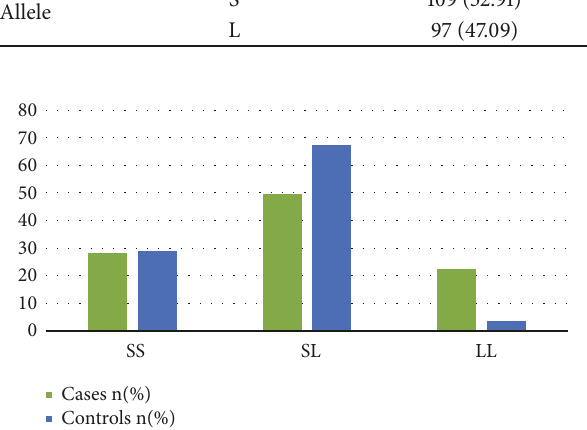
Figure 4: Prevalence of the different genotypes (SS, SL, and LL) of the Ser217Leu variant of the ELAC2 gene in isolates from the Littoral Region. SS= wild type, SL = heterozygous mutant, and LL = homozygous mutant. Frequencies of the genotypes SS, SL, and LL were, respectively, 28.2%, 49.5%, and 22.3% in prostate cancer cases and 28.8%, 67.5%, and 3.7% in the controls (p-value = 0.0012).